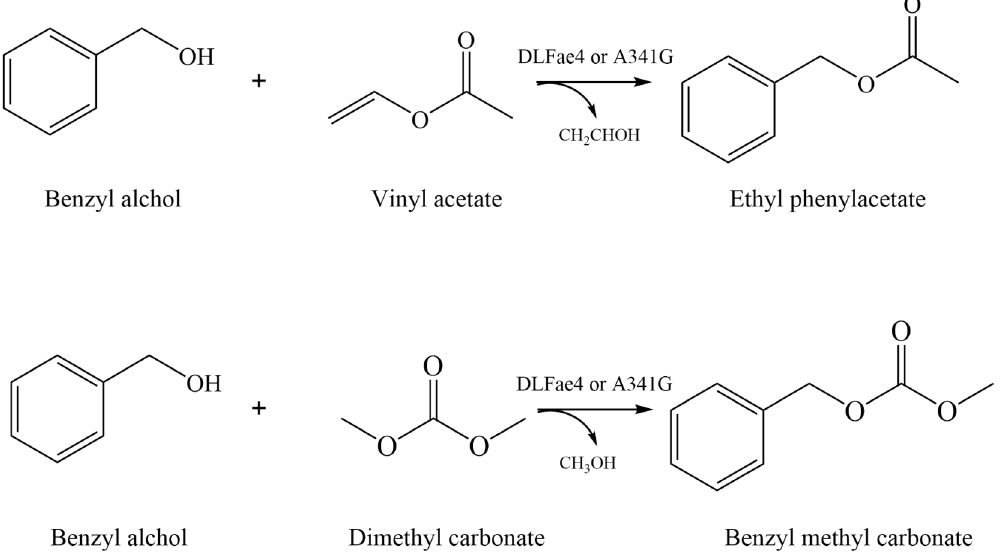
Figure 4. Enzymatic synthesis of esters and carbonates by DLFae4 or variant DLFae4 (A341G).